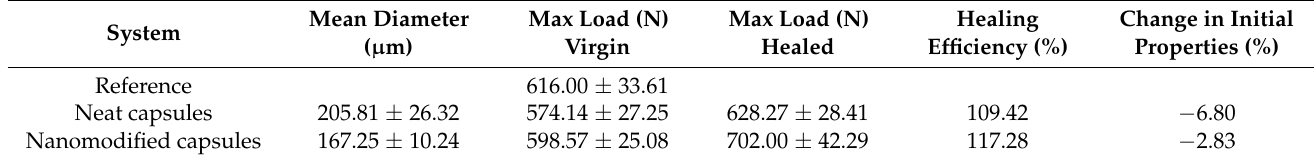
Table 2. Healing efficiency and change in initial mechanical properties of mode-II specimens con- taining neat and nanomodified capsules in terms of maximum load.